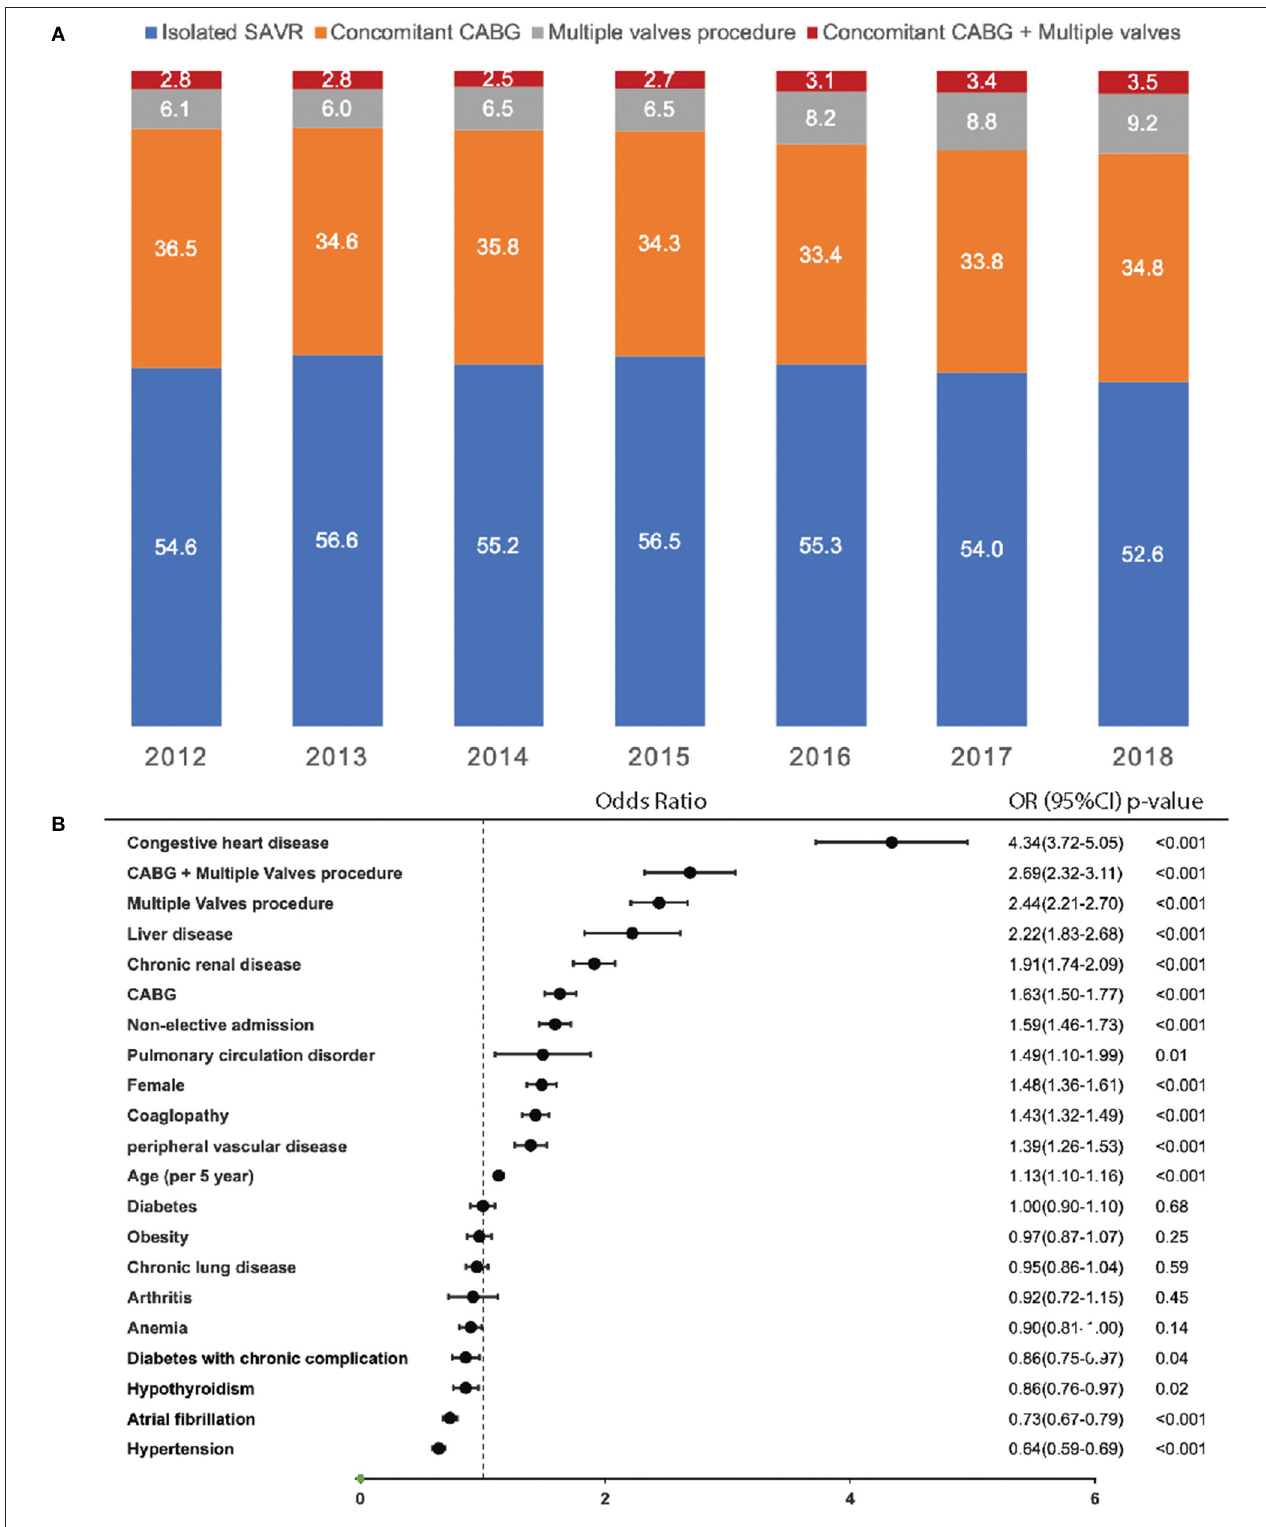
FIGURE 2 | Trend of concomitant CABG and multiple valve procedures in SAVR and predictors of in-hospital mortality. (A) Percentage of different types of procedures in SAVR from 2012 to 2018; (B) predictor for in-hospital mortality. CABG, coronary artery bypass grafting; SAVR, surgical aortic valve replacement.